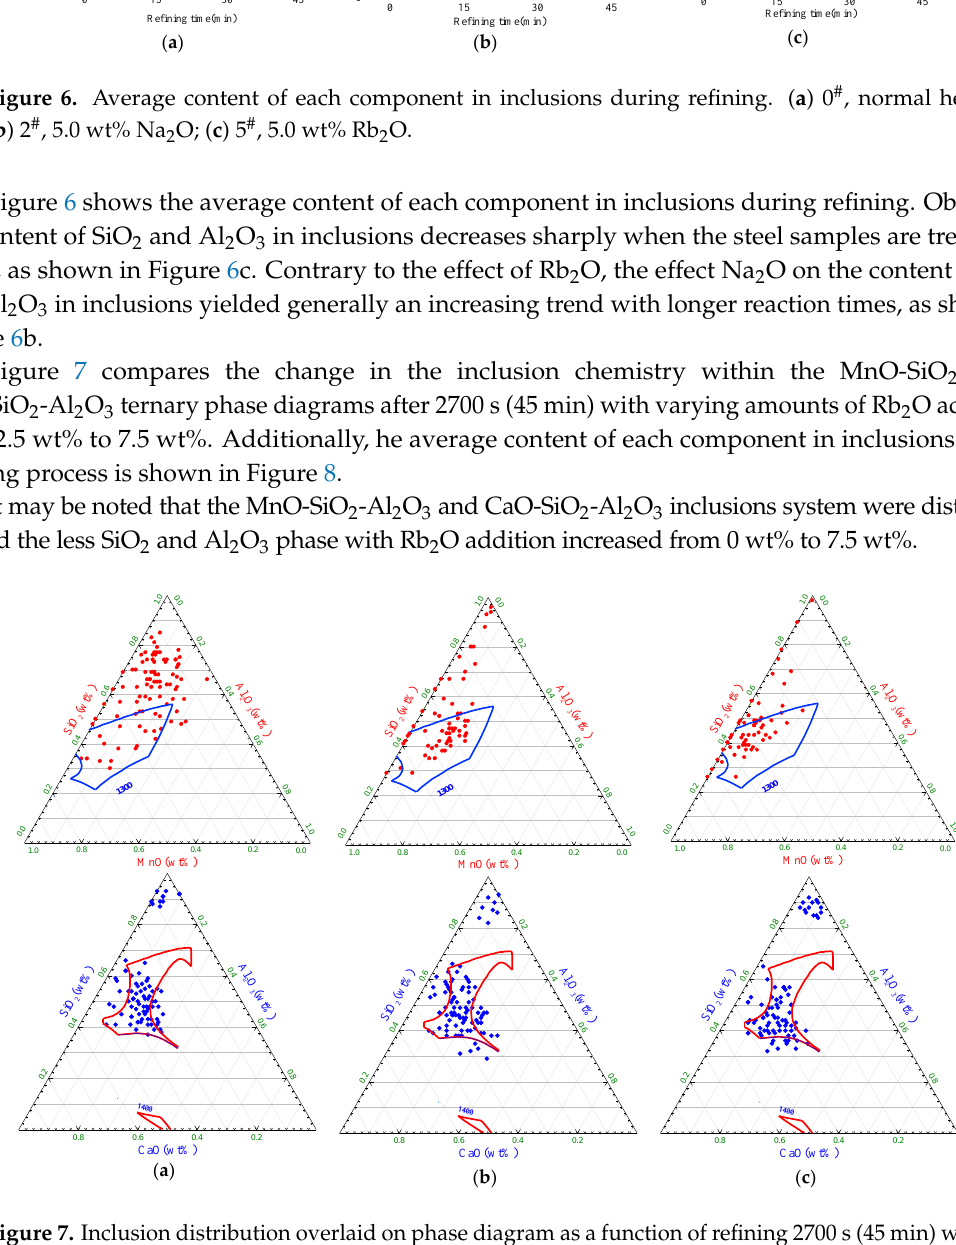
Figure 6. Average content of each component in inclusions during refining. ( a ) 0 # , normal heat; ( b ) 2 # , 5.0 wt% Na 2 O; ( c ) 5 # , 5.0 wt% Rb 2 O.